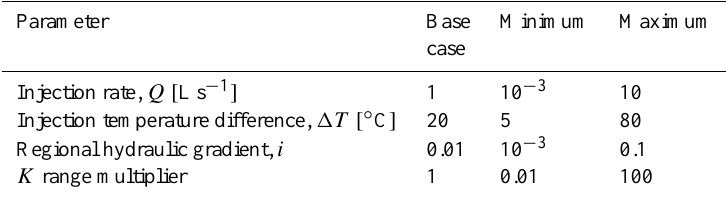
Table 2. Parameterization of experimental setups, with base values and minimum–maximum